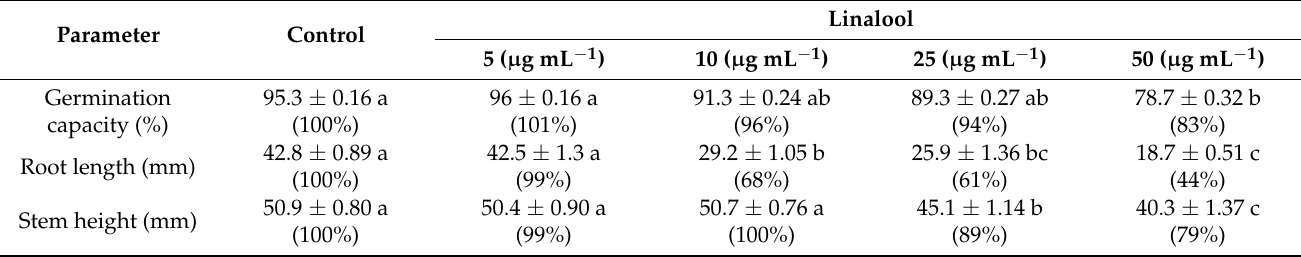
Table 3. Effect of linalool used at different concentrations (5, 10, 25 and 50 µ g/mL) on germination and growth parameters of Pinus sylvestris seedlings. Data are mean ± SE, numbers in brackets represent % of control. Different letters (a, b, c) following values in rows indicate significant differences for the tested linalool solutions determined in the Tukey HSD test or Kruskal–Wallis test with p ≤ 0.05; n =